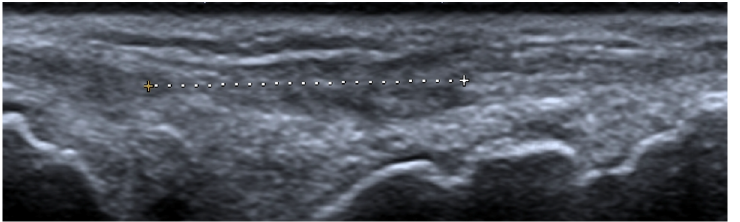
Figure 8. A long-axis gray-scale ultrasound image shows a complete tear of an extensor digitorum tendon of the middle finger at the level of the wrist (between calipers) in the same patient as in Figures 6 and 7.